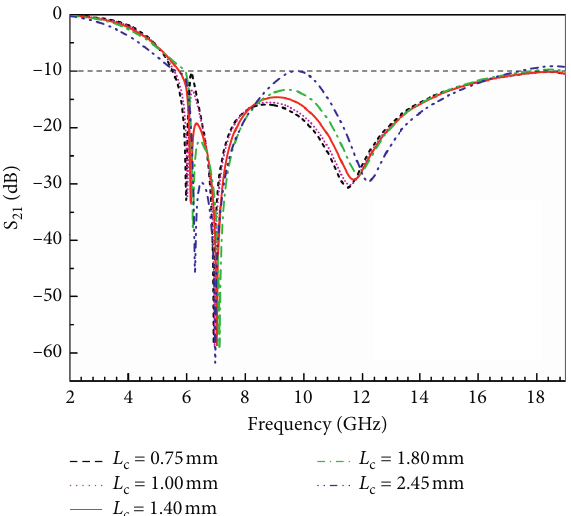
Figure 3: (a) Schematic illustrating the circular head open stub and novel DGS: (b) simulated S and circular stub with DGS, respectively.